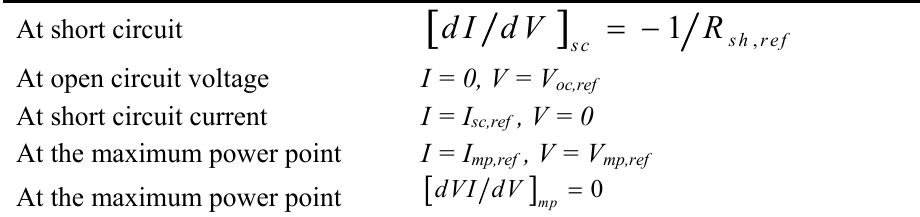
Table 1. Conditions used to estimate five parameters.